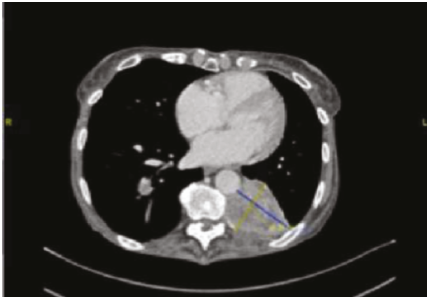
Figure 4: Restaging CT post 19 cycles of Nivolumab. There was a tumour regression in the RLL and LLL